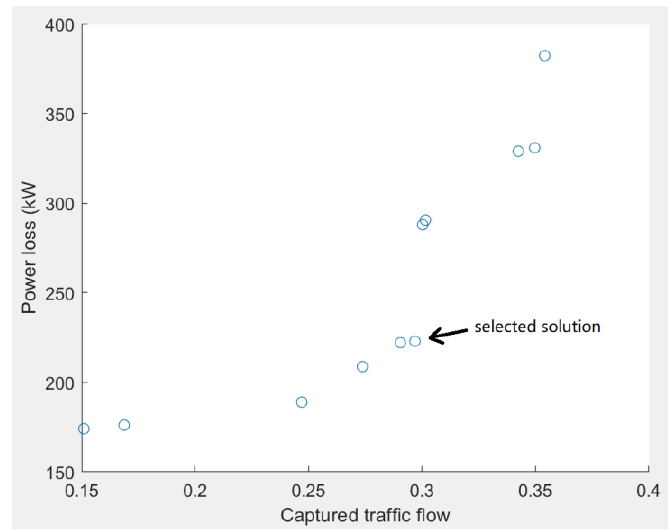
Figure 10. Pareto frontier, obtained by the proposed model. Table 5. Result of the selected